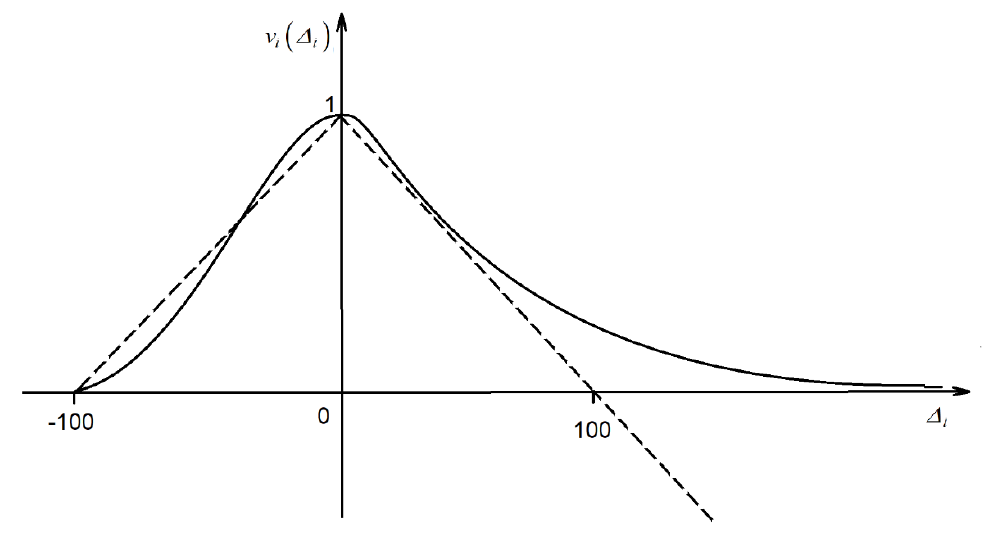
v . over an emission deviation (continues line). The i